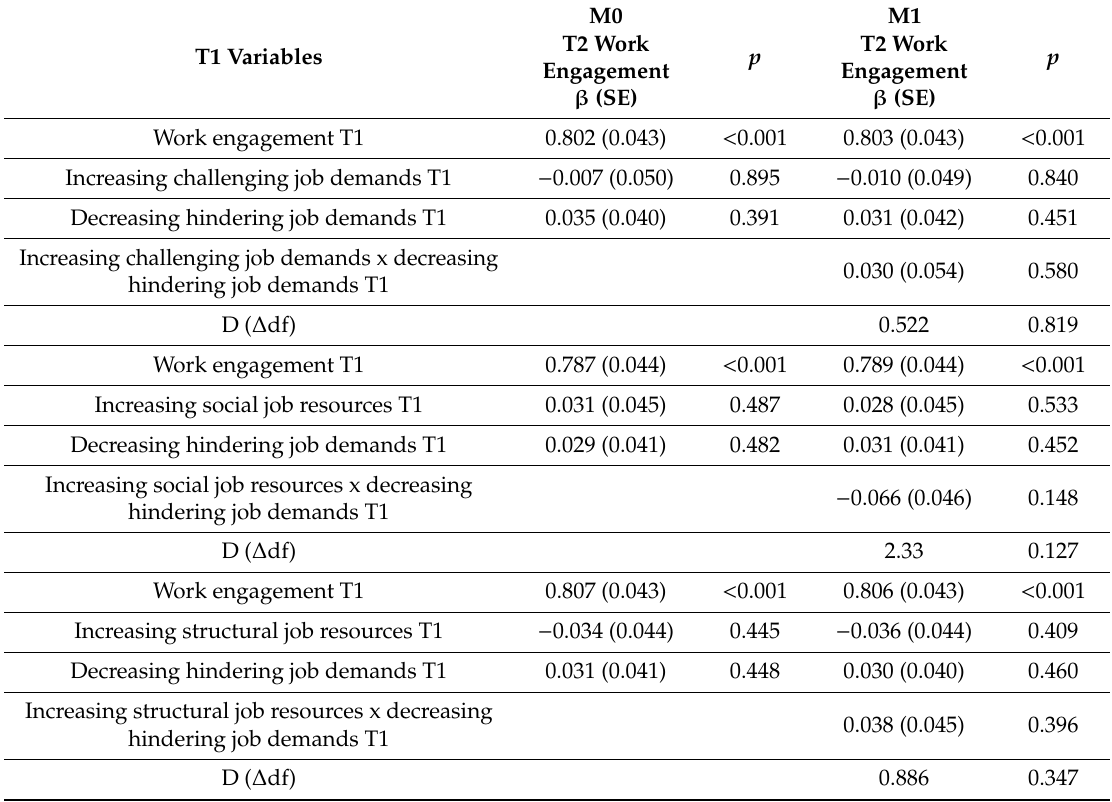
Table 5. Results of LMS: interaction e ff ects of job crafting dimensions on work engagement among participants not facing changes in work content ( n =